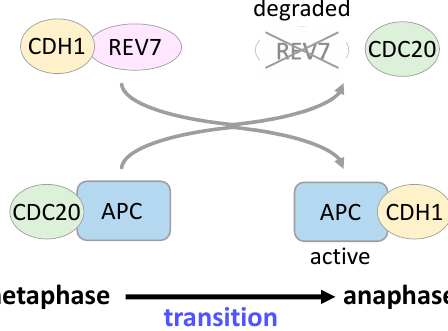
Figure 4. REV7 involvement in the mitotic checkpoint. REV7 binds to CDH1 to sequester it from APC in prometaphase, and APC–CDC20 degrades REV7 in early anaphase; released CDH1 activates APC, leading to a transition from metaphase to anaphase.